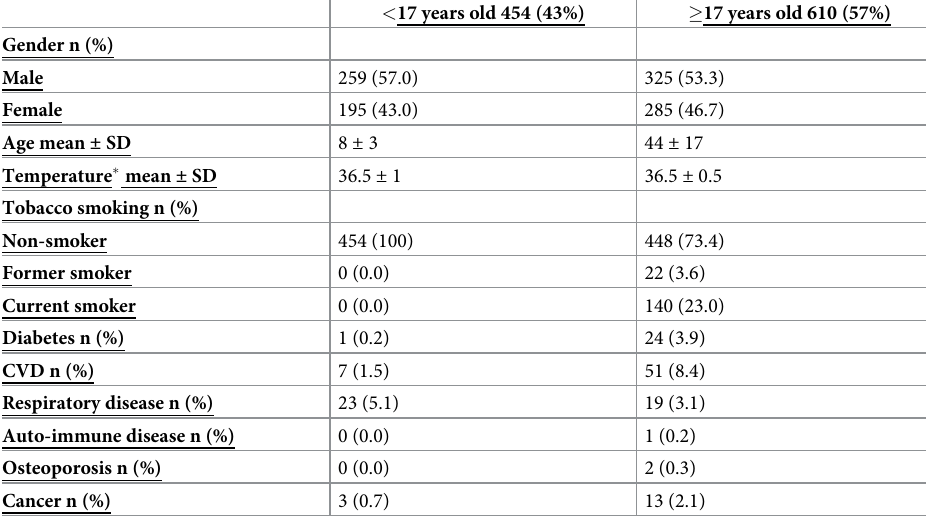
Table 1. Characteristics of the sample (n =